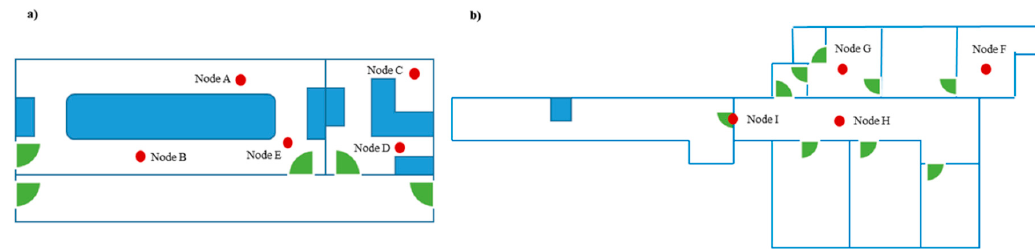
Figure 13. A schema of the indoor scenes in which doors are represented in green, main pieces of furniture in blue, and indoor positions selected as origin nodes in red: ( a ) case studies 1, 2, and 3; ( b ) case study 4.